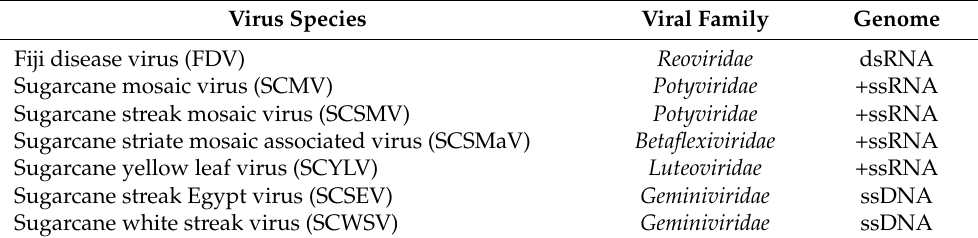
Table 1. Sugarcane RNA and DNA viruses used in this